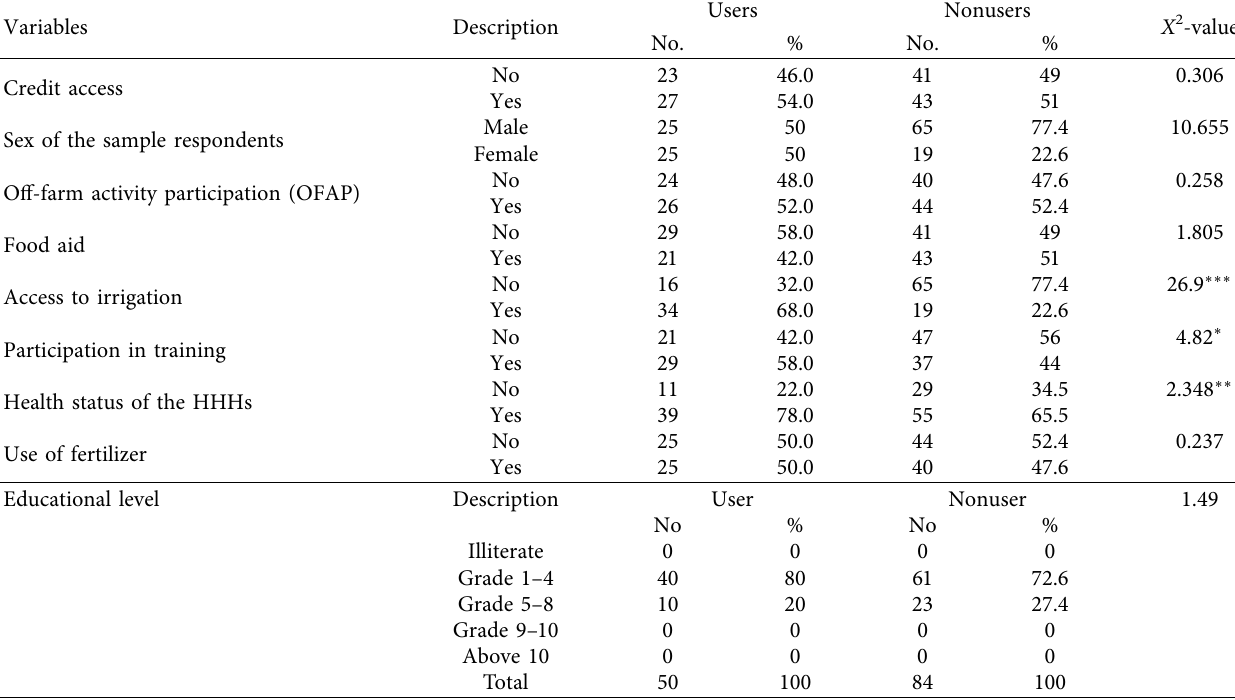
Table 4: Statistical summary of users and nonusers sampled on dichotomous